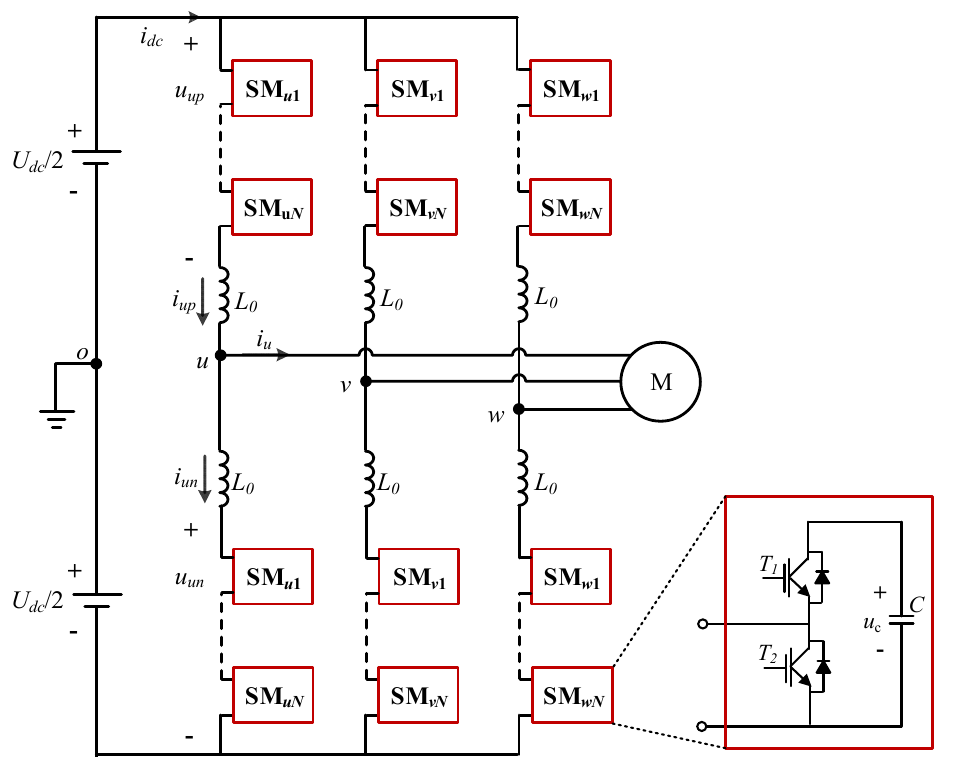
Figure 1. Circuit diagram of one phase of MMC.